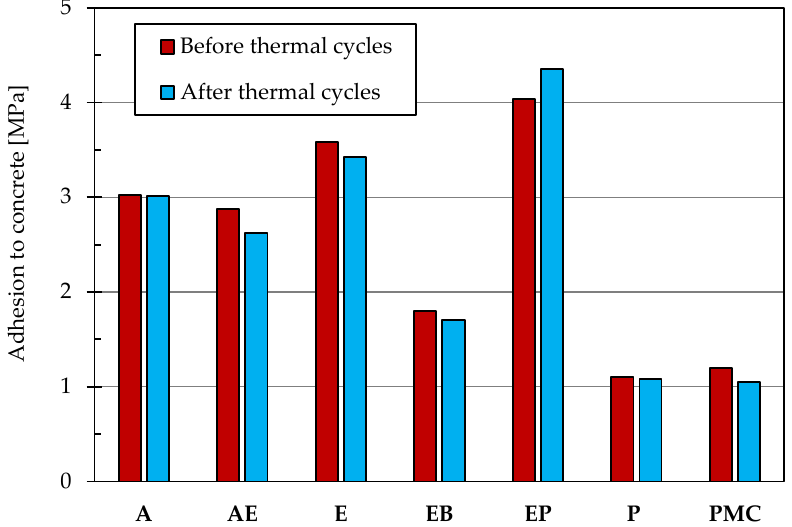
Figure 1. Adhesion to concrete before and after 50 freeze/thaw cycles with deicing salts.